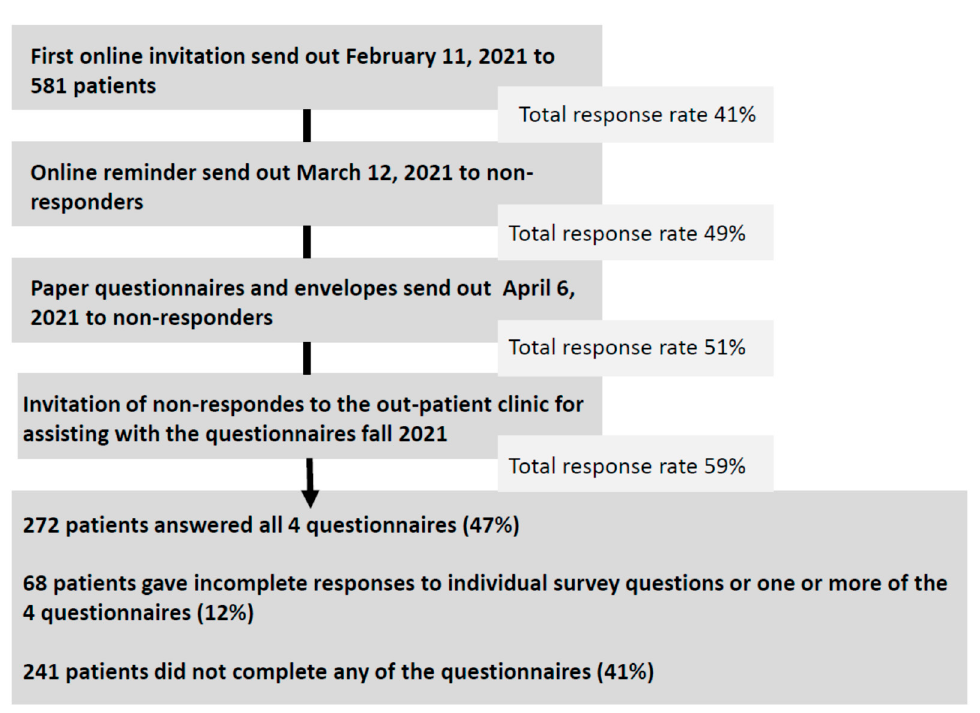
Figure 1. Survey invitation log and response rates. Baseline demographic and disease characteristics for the responders are presented in Table 2. The median age for all responders was 61 years, and 40% were women. Of the responders, 266 had liver disease without cirrhosis and 74 patients had cirrhosis. More patients with cirrhosis were male (64% versus 44%), fewer worked full time (16% versus 32%), more were smokers (35% versus 21%), and they had a higher AUDIT score (10, IQR 4–15 versus 5, IQR 2–7) compared to patient with liver disease without cirrhosis (Table 2). More patients with alcohol-related cirrhosis were single (36% versus 21%), were disability pensioners or chronically sick (34% versus 13% and 4% versus 0%), and were smokers (45% versus 18%) compared to patients with non-alcoholic cirrhosis.